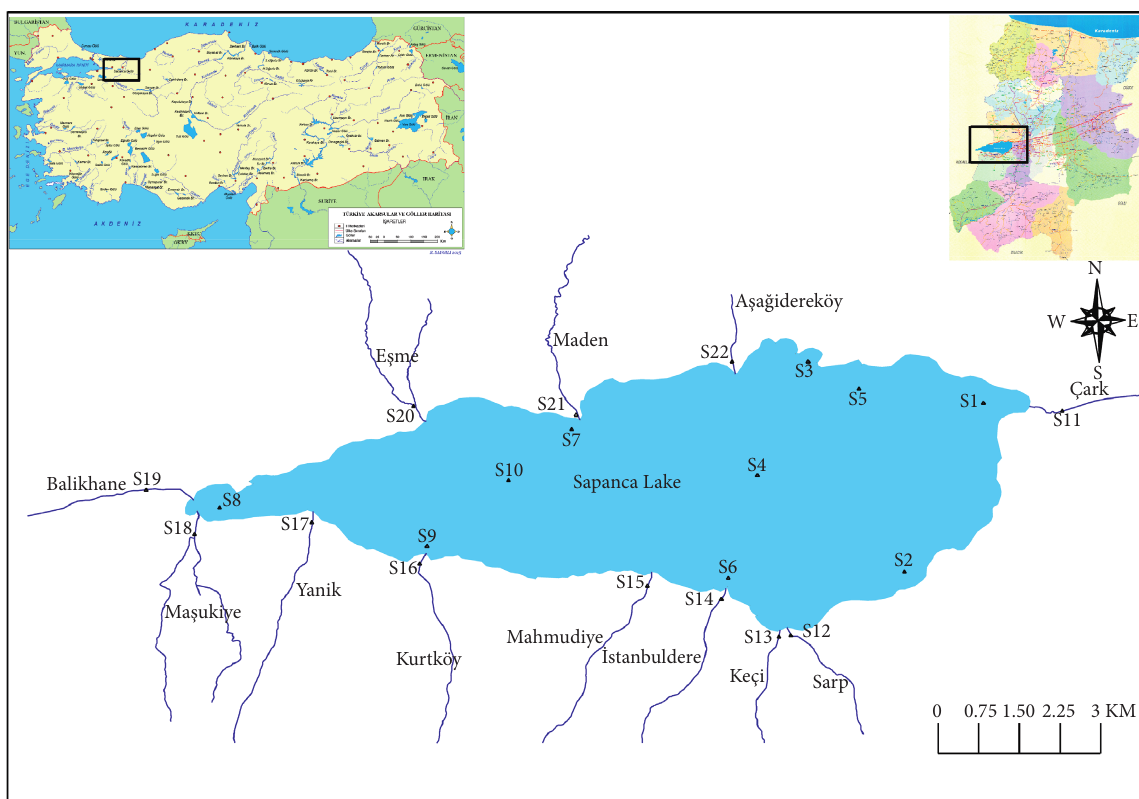
Figure 1: Monitoring points of water samples in Sapanca Lake, Sakarya,